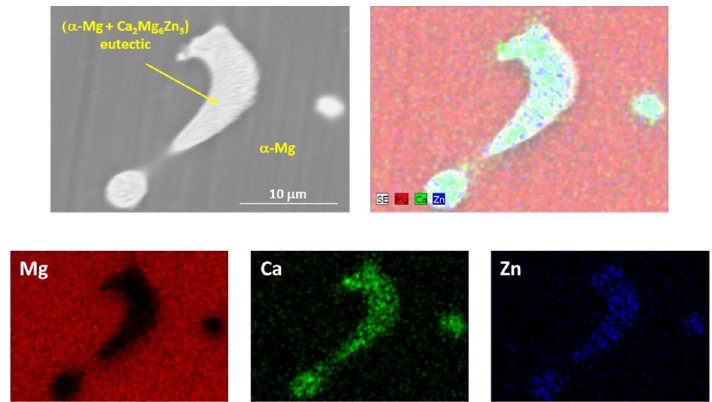
Figure 1. SEM micrographs of the ZX30 alloy samples: ( a ) as-cast, ( b ) solution-treated, ( c ) peak- aged, and ( d ) over-aged.